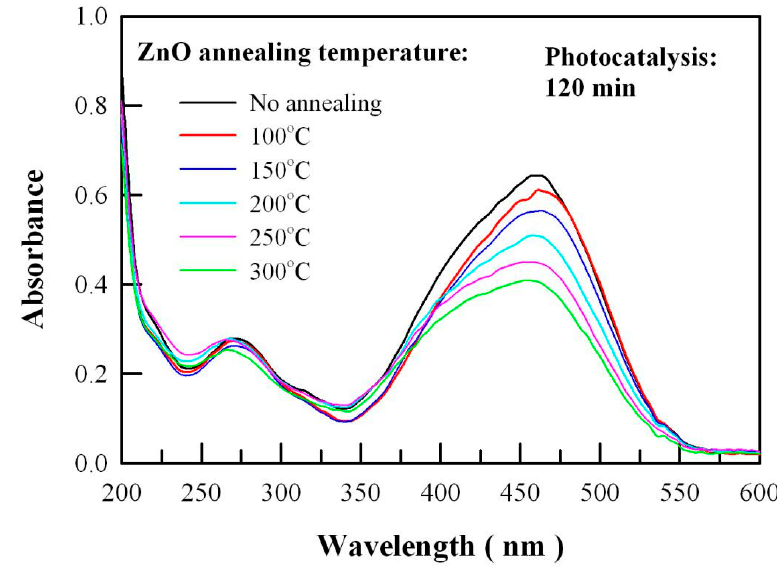
Figure 10. UV-Vis absorption spectra of aqueous methyl orange solutions after 120-min visible-light photocatalysis of thermally-annealed ZnO nanocrystals.